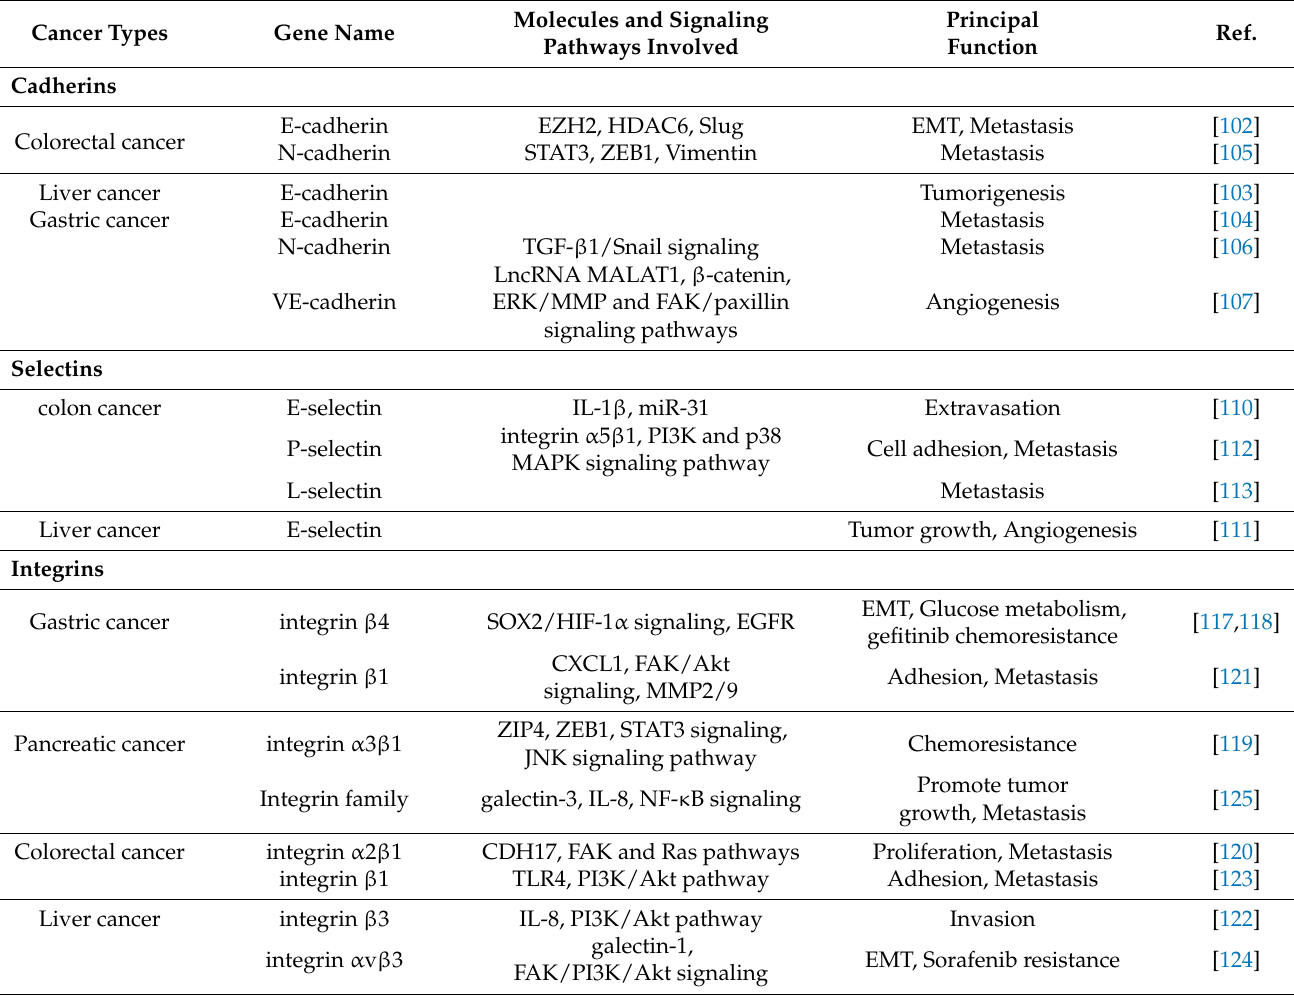
Table 2. Cell adhesion molecules and their potential mechanisms in gastrointestinal